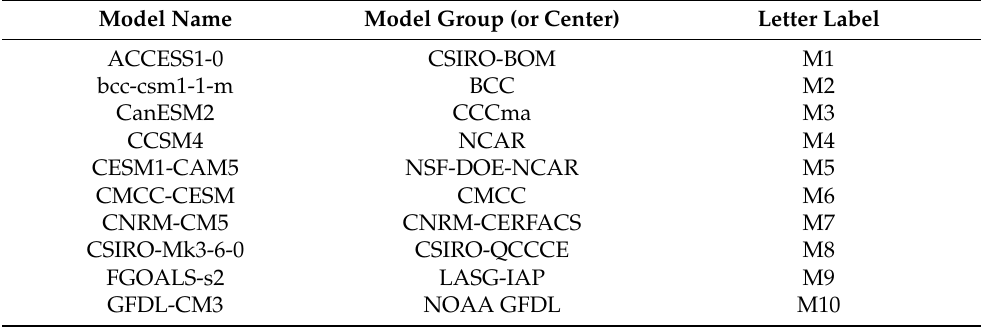
Table 1. A list of the 22 models used in this work and the letter labels used to denote them in the text and